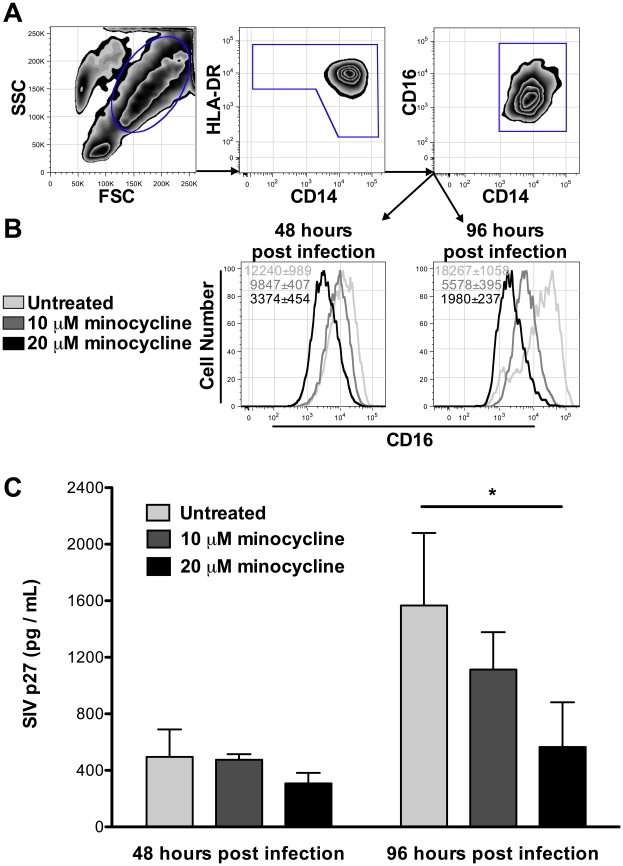
Reduction of CD16 expression and viral replication in CD14+ monocytes during in vitro minocycline treatment.CD14+ monocytes were infected with SIVmac316STOP virus and cultured with M-CSF in the presence or absence of minocycline for 24 and 72 hours. With M-CSF treatment, all monocytes expressed CD14 and CD16 prior to minocycline treatment. By flow cytometry, monocytes were first gated based on size (FSC) and granularity (SSC). From this gate HLA-DR+ CD14+ monocytes were selected (A) and CD16 expression on these cells between treatment groups was compared. Histograms represent the median fluorescence intensity (MFI) of CD16 from one representative experiment out of three (B). Averages of MFI ± standard error of the mean in a given treatment group are indicated in the upper left hand corner of the graphs. CD16 expression was significantly higher on untreated than 20 µM minocycline treated monocytes at 48 hours pi (p = 0.021). Untreated monocytes had significantly higher CD16 expression than both 10 µM and 20 µM treated cells at 96 hours pi (p = 0.001). After 96 hours of infection, SIV-p27 was reduced with minocycline treatment (C), with significant differences between control and 20 µM minocycline (p = 0.039). Studies presented here are the results of n = 3 three independent experiments with n = 3 animals per experiment performed in triplicate wells. P values were determined using a Mann-Whitney U test.